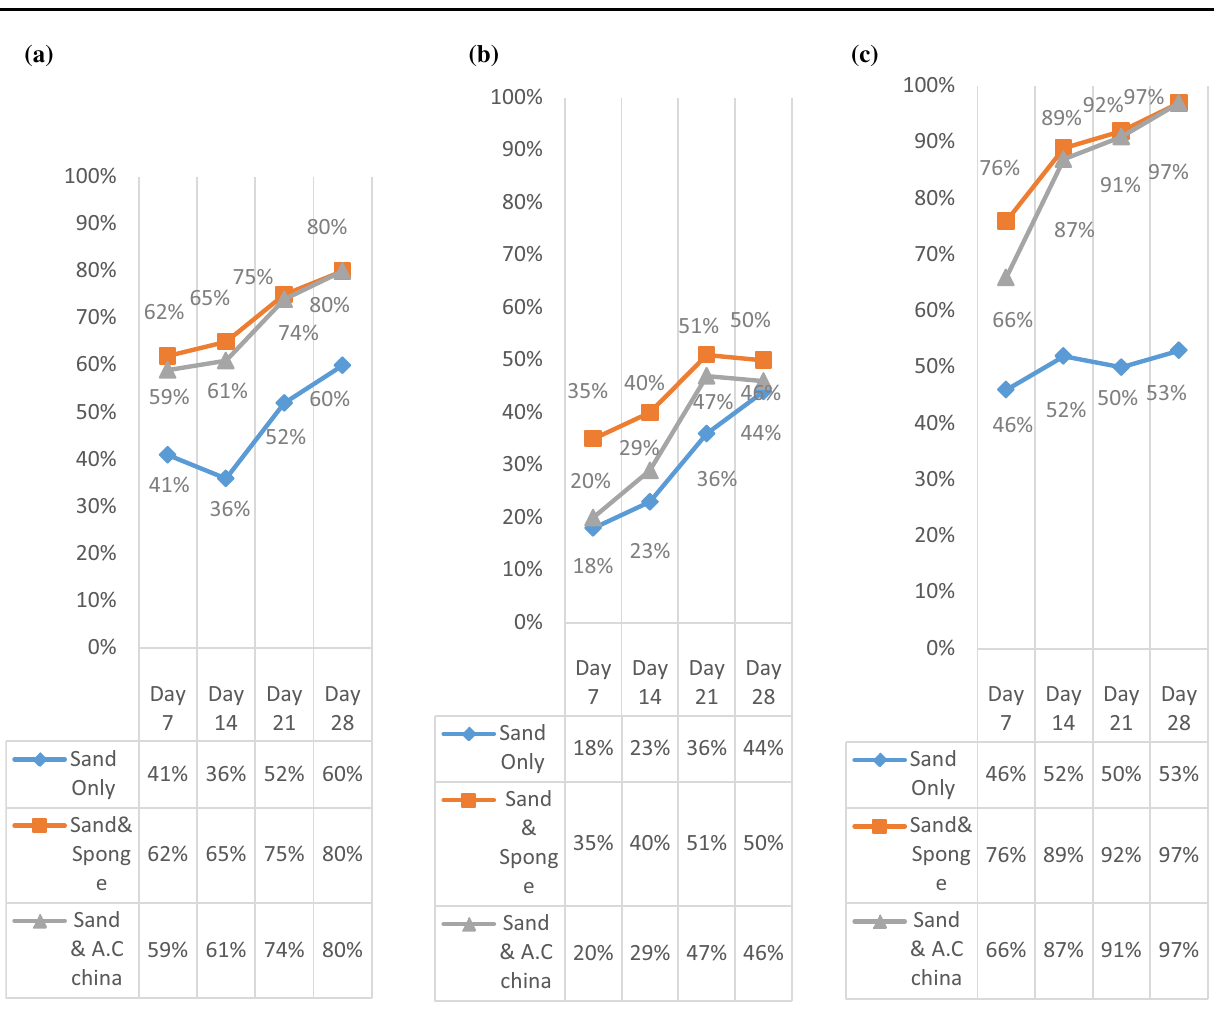
tot for different media, b %R.E. of COD sol for different media, c %R.E. of TSS for different